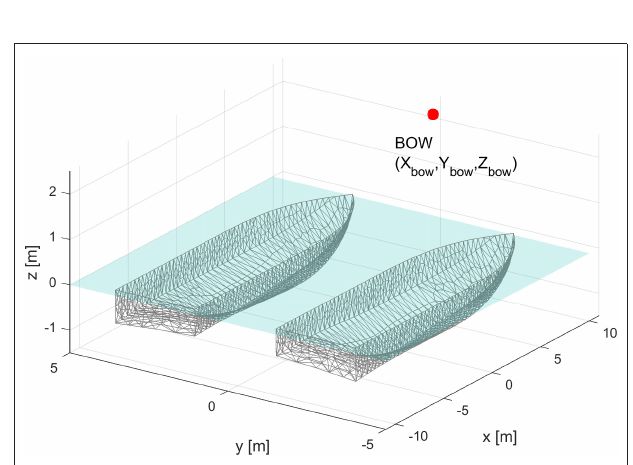
FIGURE 5 | Hull of the CTV employed in the S-Omega simulations to derive the RAOs. The red marker is the reference point used as the bow (X bow = 10.20 m, Y bow = 0 m, Z bow =